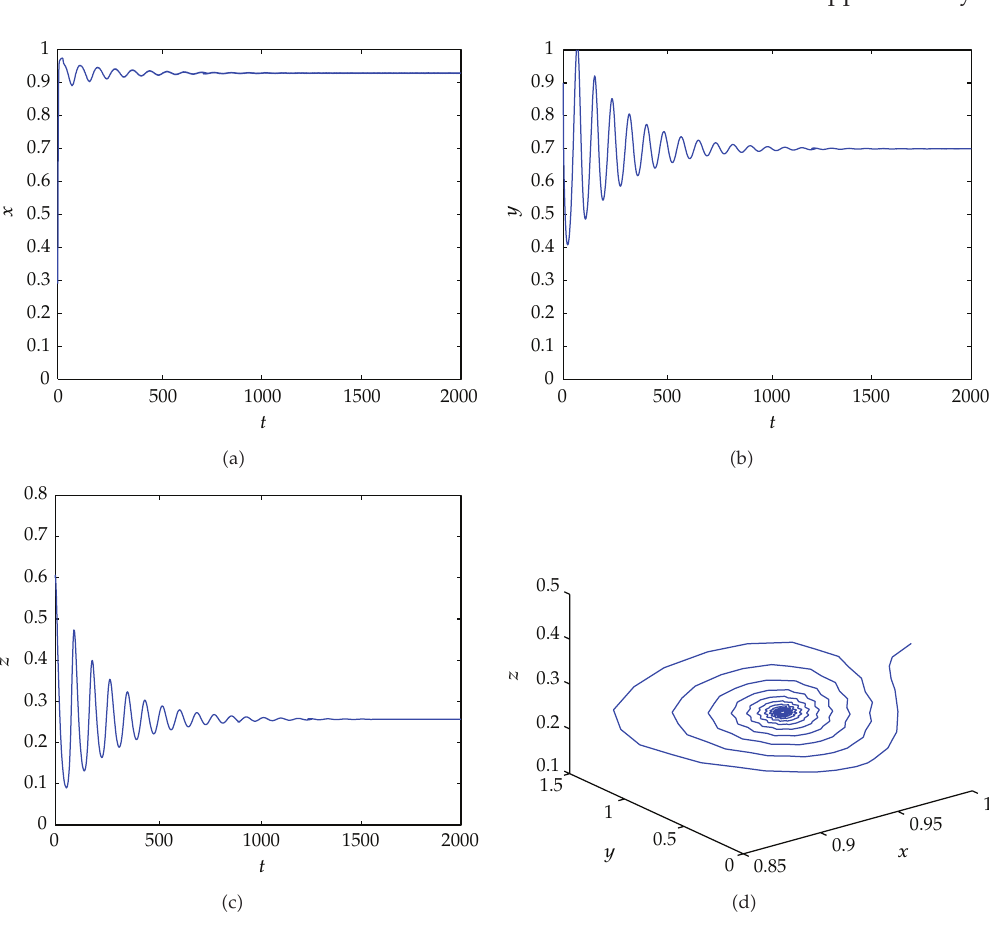
Figure 2: E (cid:6) 0.9977, 0.6954, 0.4432 (cid:7) with initial value (cid:6) 0.985, 0.135, 0.4 (cid:7) is asymptotically stable when τ (cid:8) 8 . 6017 < τ 0 (cid:8) 12 .